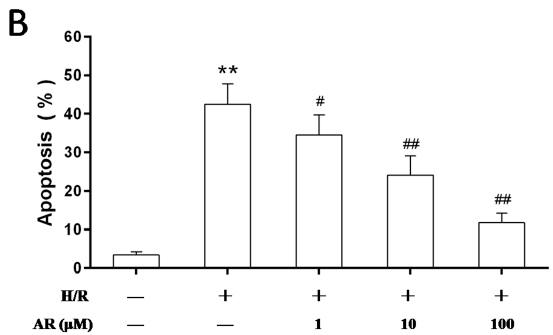
Figure 4. Protection effects of AR against H/R-induced H9c2 cardiomyocytes apoptosis. Pretreatment with AR (1, 10, 100 μ M) for 24 h prior to H/R, morphology and apoptosis of H9c2 cardiomyocytes were assessed by DAPI and TUNEL staining. ( A ) Representative images of TUNEL-positive cells (green, first row) and DAPI counterstaining (blue, middle row). Scale bar: 50 μ m; ( B ) The histogram shows the relative proportion of TUNEL-positive cells in experimental groups. Values are mean ± S.D ( n = 5). **: p < 0.01 vs. control group; # : p < 0.05 vs. H/R group; ## : p < 0.01 vs. H/R group.